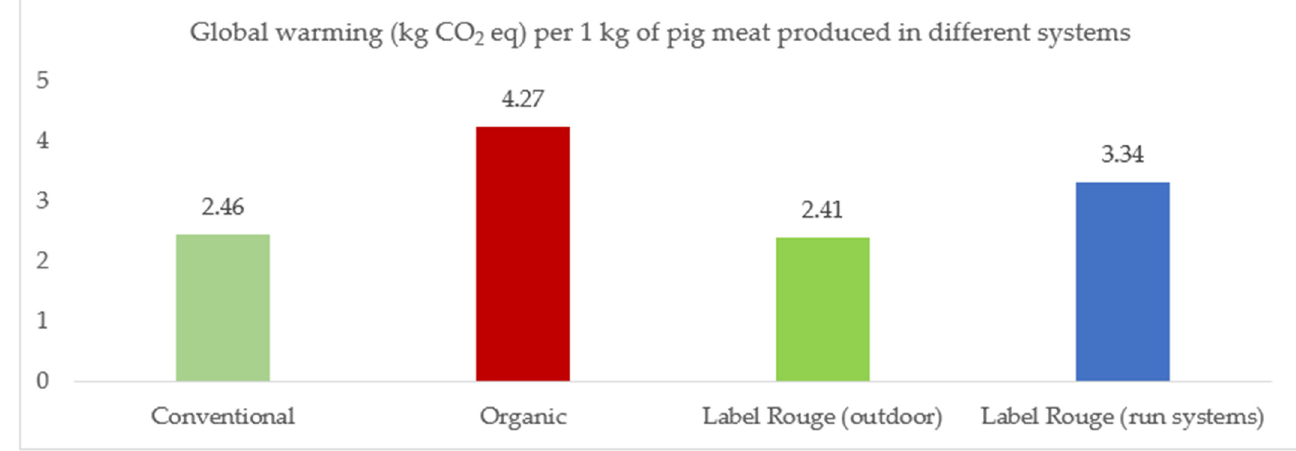
Figure 6. Terrestrial ecotoxicity per 1 kg Pig meat across organic, Label Rouge and Conventional systems: Data obtained from AGRIBALYSE ® database and computed using OpenLCA 1.10.2 [35,36]. Figure 7. Terrestrial Acidification per 1 kg Pig meat across organic, Label Rouge and Conventional systems: Data obtained from AGRIBALYSE ® database and computed using OpenLCA 1.10.2 [35,36]. The Label Rouge (national standard outdoor system) had the best performance across all the indicators compared to the organic system. The performance can be attributed to increased efficiency and resource utilisation across the conventional system. The results